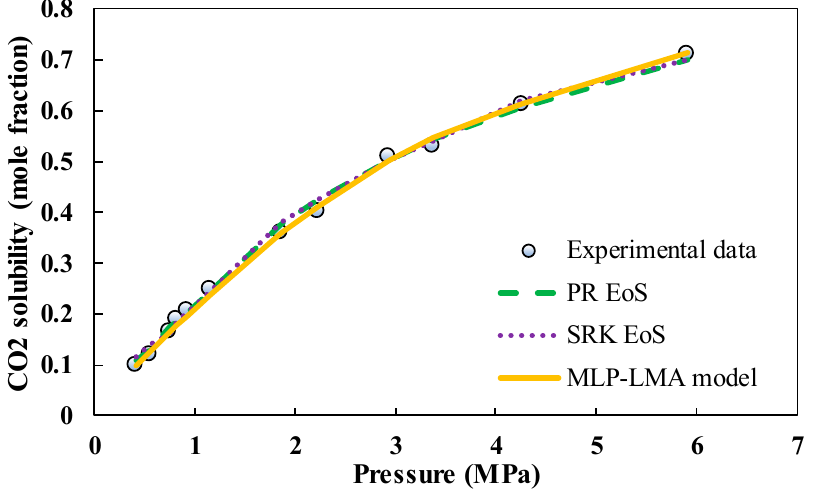
Figure 5. Comparison of PR and SRK EoS, and MLP-LMA model for prediction of CO 2 solubility in [bmim][Tf2N] at T = 298.15 K.